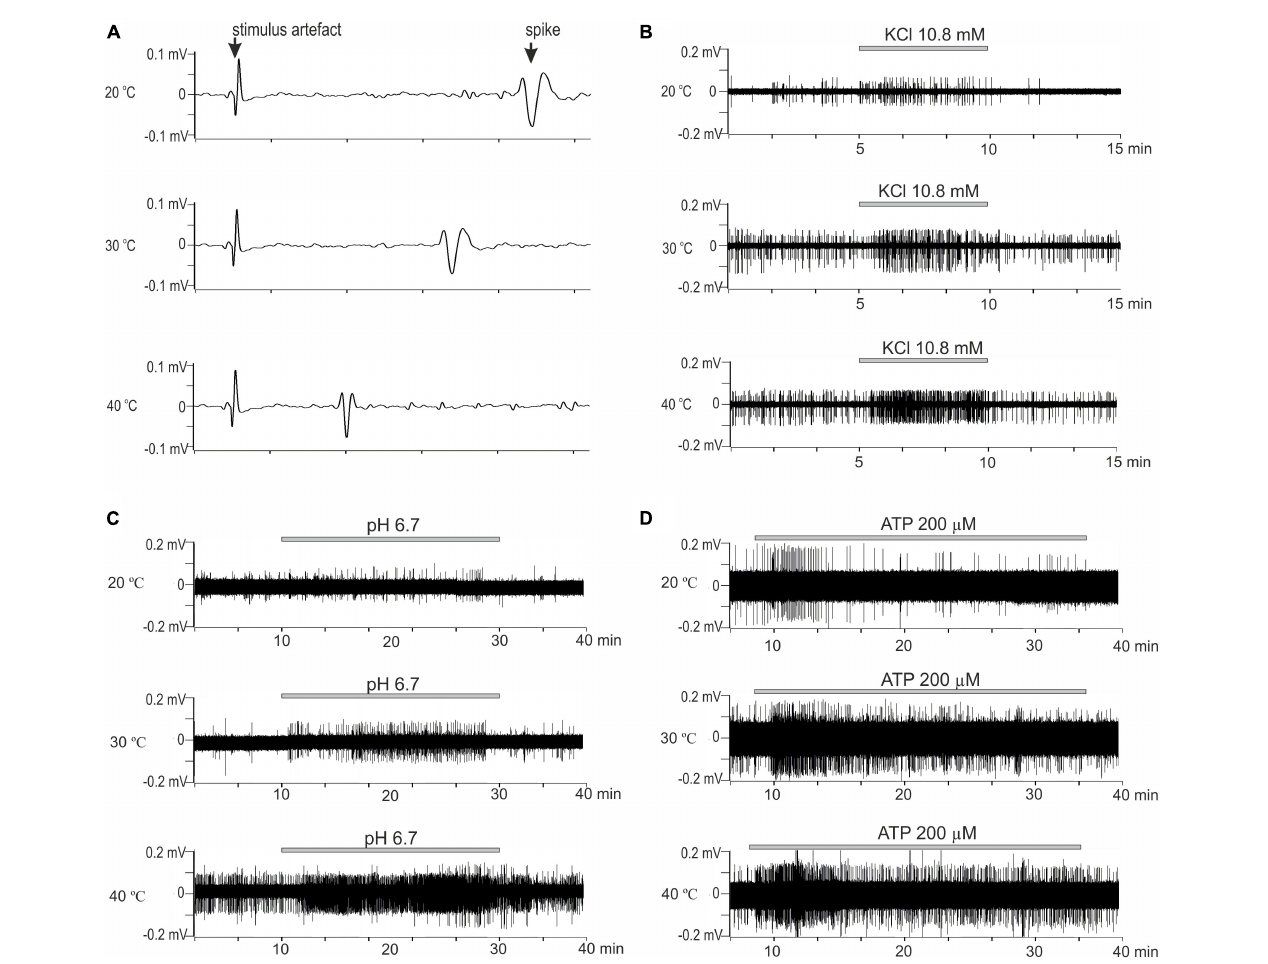
FIGURE2 (A) Representative example recording of activity from the skin CMH-afferents. Three consecutive recordings from a C-fiber in response to electrical stimulation at 20, 30, and 40 ◦ C. Sweeps show the change in the conduction velocity and waveform of the action potential with a temperature change. Increasing temperature results increase in conduction. Arrow indicates artifact from electrical stimulation and action potential; x -axis: delay in ms; y -axis: voltage signal amplitude. (B–D) The original recordings showed responses of nerve filaments with CMH-fibers to chemical stimulation by irritants at 20, 30, and 40 ◦ C. (B) Stimulation by high K + (10.8 mM) for 5 min. (C) Stimulation by low pH solution (pH 6.7) for 20 min. (D) Stimulation by ATP 200 µ M for 20 min (25 min of control recordings before and after ATP application not